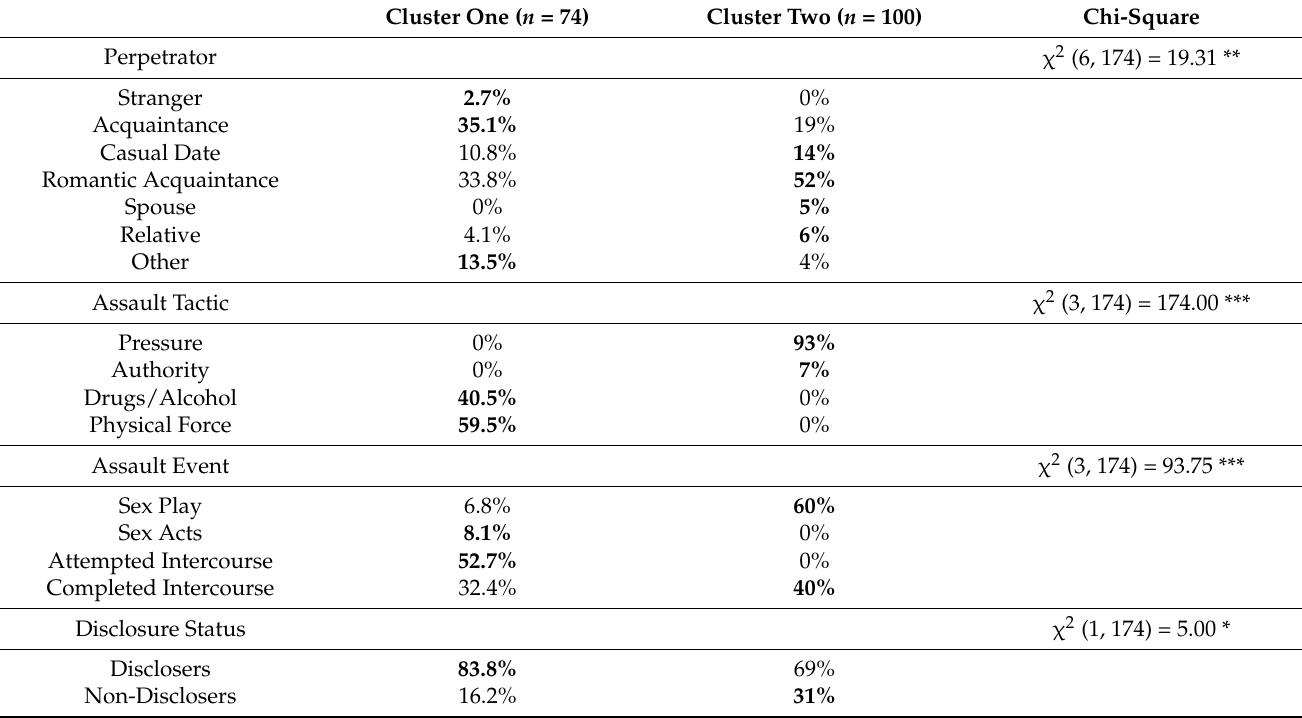
Table 2. Criterion Variables by Cluster